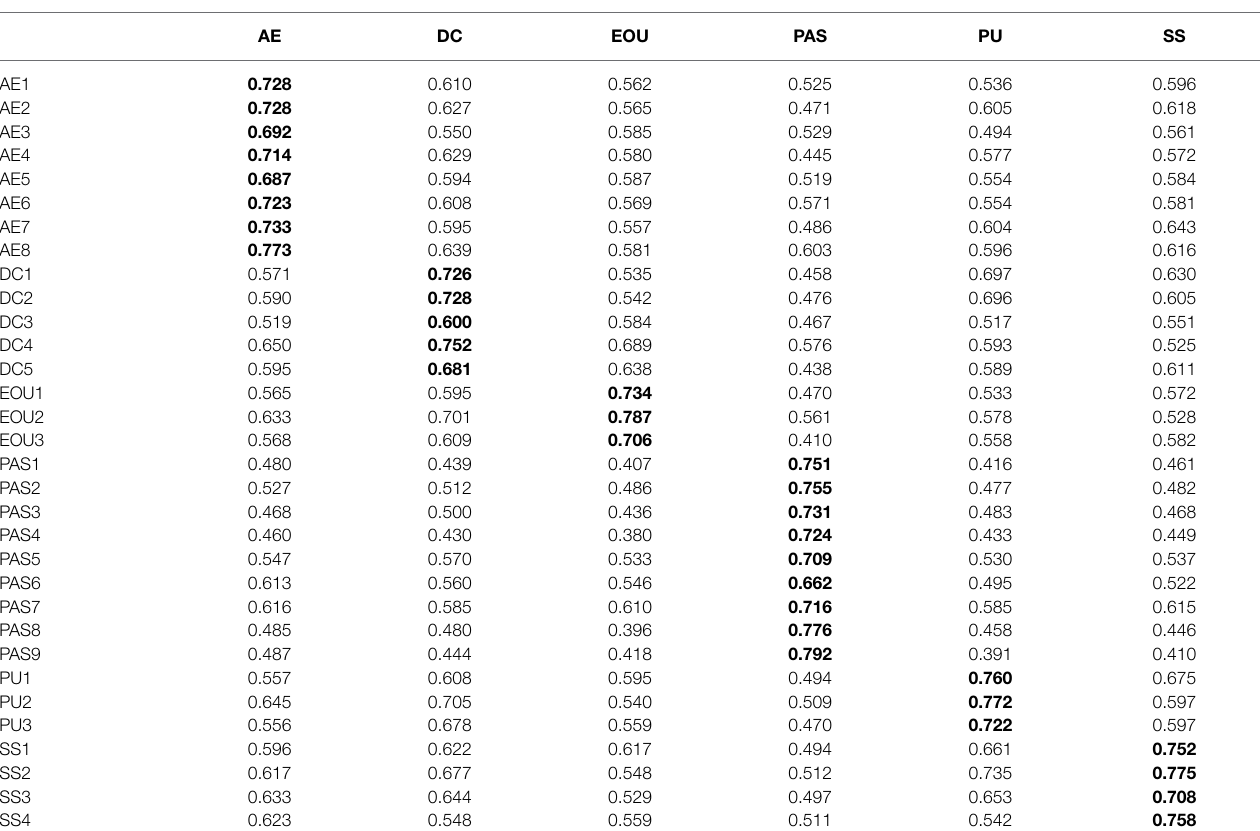
TABLE 3 | Cross loadings.